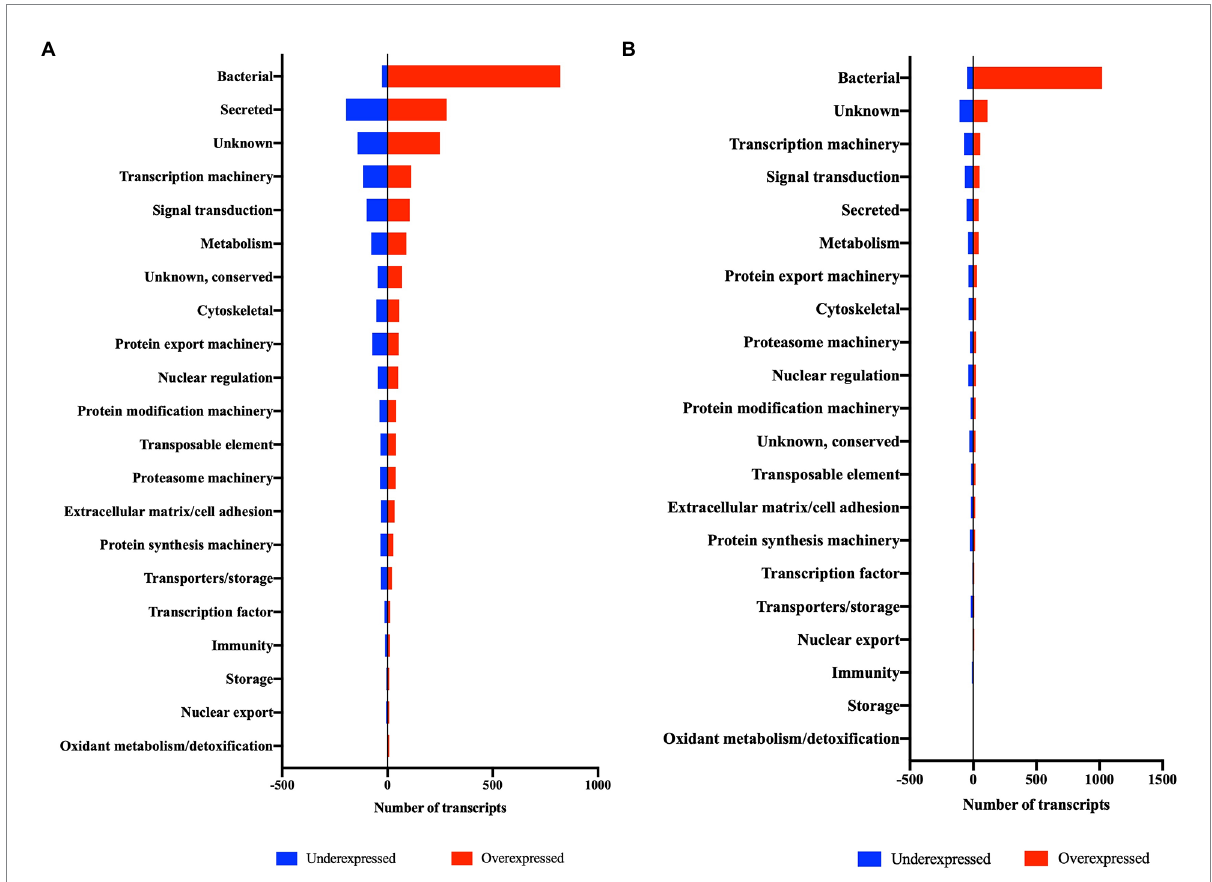
TABLE 2 Bacterial differentially expressed transcripts (DET) in ovary and salivary glands in response to R . parkeri infection. Bacterial genera